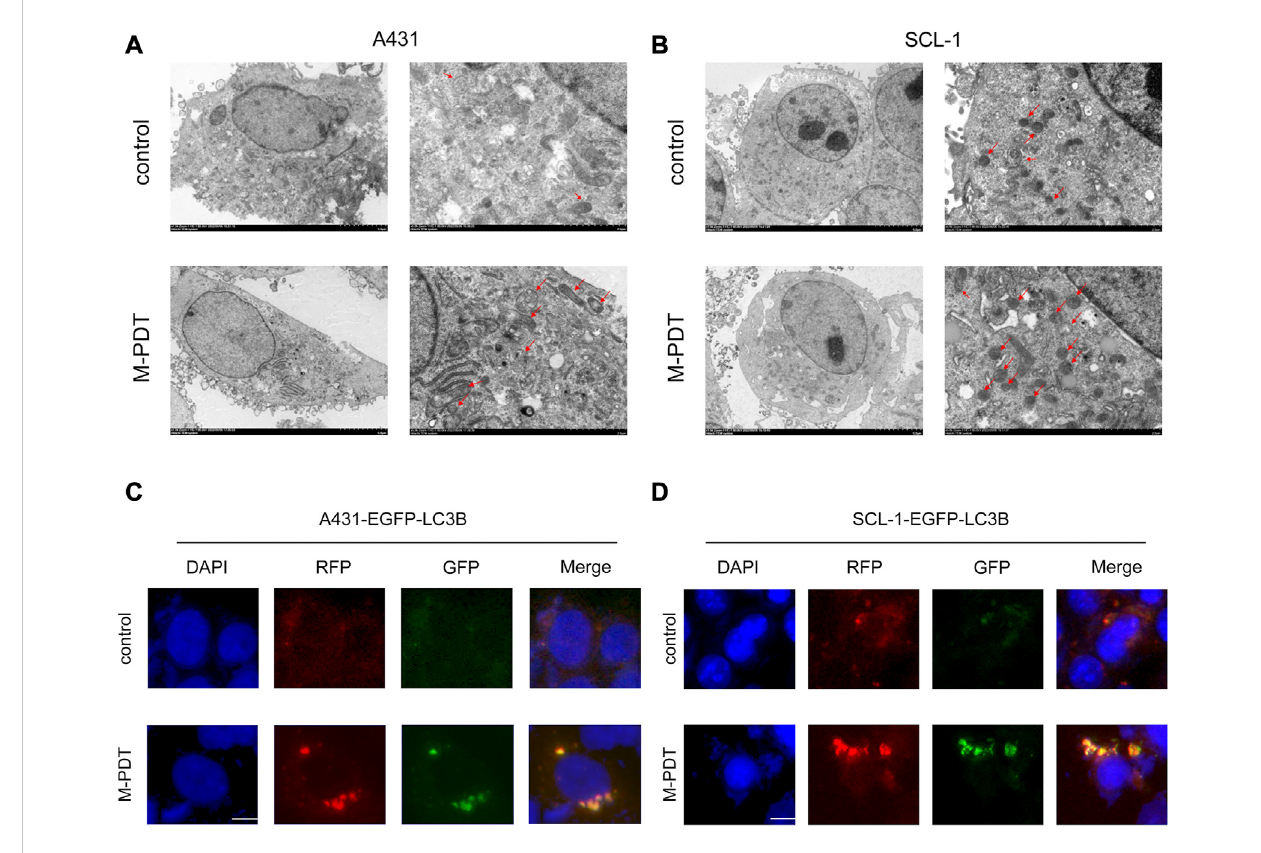
FIGURE 3 M-PDTimpairsautophagic fl uxofcSCCcells. (A,B) Cellstructureisdetectedbytransmission electronmicroscopy,theredarrowshowsautophagic vacuoles. (C, D) Representative images of fl uorescence analysis of autophagic fl ux in cSCC cells. The scale bar is 10 μ m. n =